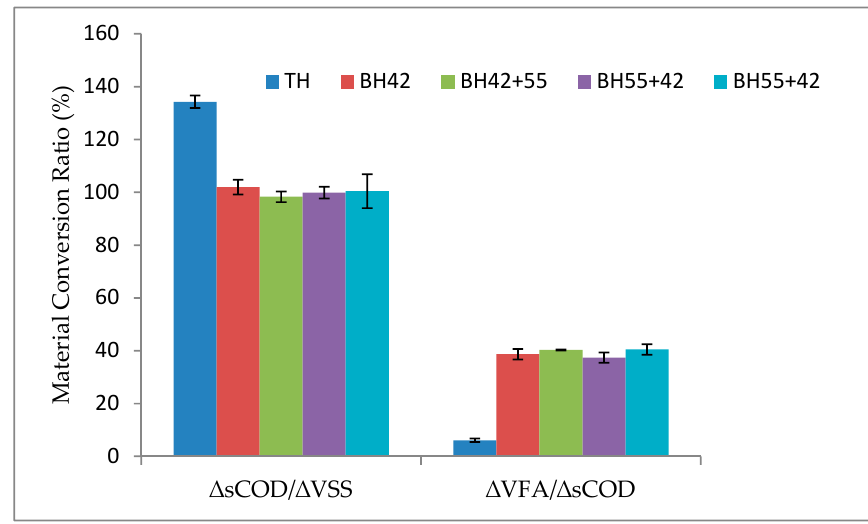
Figure 4. Material conversion ratios of ∆ sCOD/ ∆ VSS and ∆ VFA/ ∆ sCOD due to TH and BH treatments. Table 2. Concentrations of VFA constituent after TH and BH treatments. BH42: BH at 42 °C, BH42+55: BH at 42 °C followed by 55 °C, BH55+42: BH at 55 °C followed by 42 °C, BH55: BH at 55 °C.